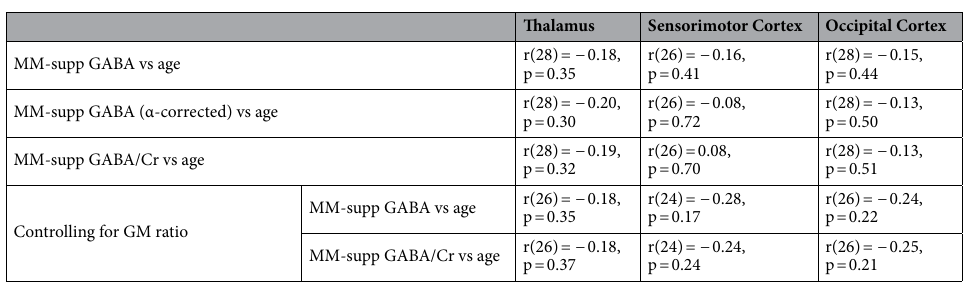
Table 1. Correlations between MM-supp GABA measures and age (months).